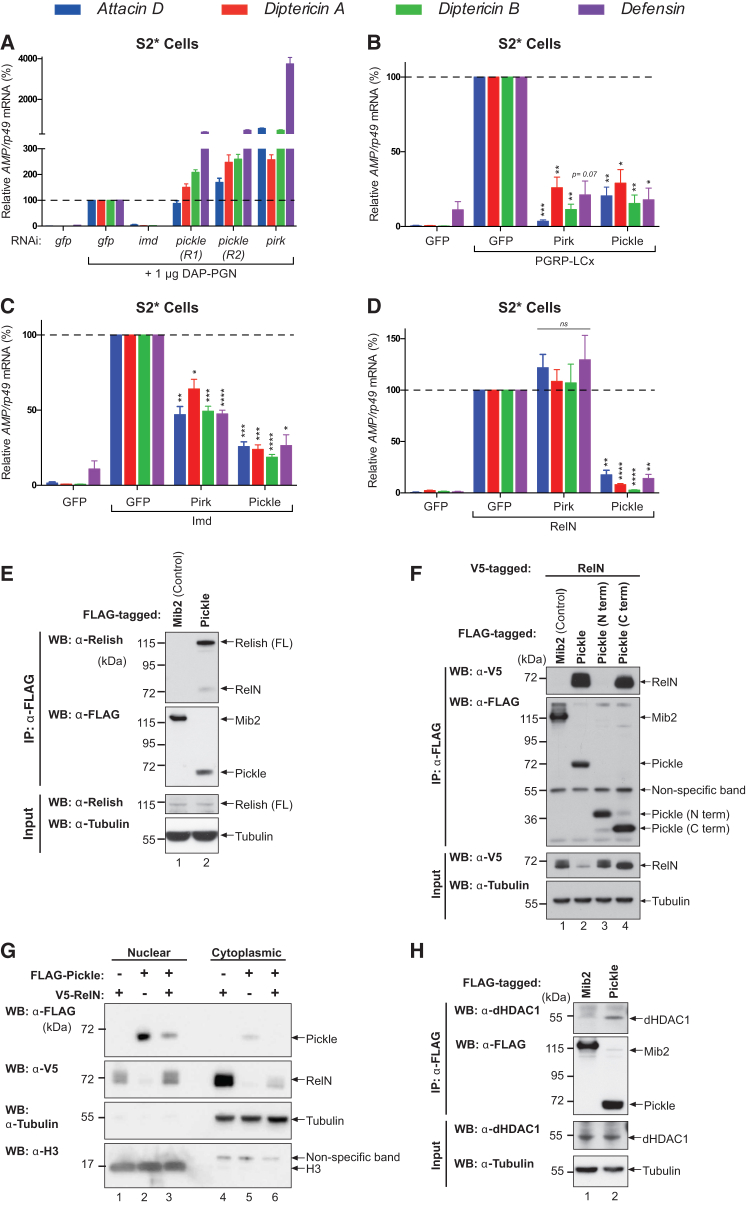
Pickle Negatively Regulates Relish(A–D) qRT-PCR analysis of mRNA from S2∗ cells. (A) Relative AMP mRNA levels before and after 4 hr of treatment with DAP-PGN in the presence of the indicated double-stranded RNAs (dsRNAs). R1 and R2 depict dsRNAs targeting two non-overlapping regions (R) of pickle. (B–D) Relative AMP mRNA levels of S2∗ cells transiently transfected with the indicated constructs. V5-tagged RelN was used.(E and F) FLAG immunoprecipitation of the indicated proteins was performed in S2∗ cells, and Relish binding was assessed via western blot.(G) Nuclear and cytoplasmic extracts of S2∗ cells transfected with the indicated proteins were analyzed by western blot. Equal total protein was loaded for both extracts.(H) FLAG-tagged Pickle and FLAG-tagged Mib2 (control) were expressed in S2∗ cells. FLAG immunoprecipitation was performed and binding of endogenous dHDAC1 to Pickle, or Mib2, was assessed via western blot.Histograms express results as percentage of a control sample (marked with dotted line). Unless otherwise indicated, p values were calculated from control using an unpaired Student’s t test. Results are representative of three (B–H) or two (A) biological repeats. Mean ± SEM of biological (B–D) or experimental (A) repeats. ∗p ≤ 0.05, ∗∗p ≤ 0.01, ∗∗∗p ≤ 0.001, and ∗∗∗∗p ≤ 0.0001. See also Figure S1.